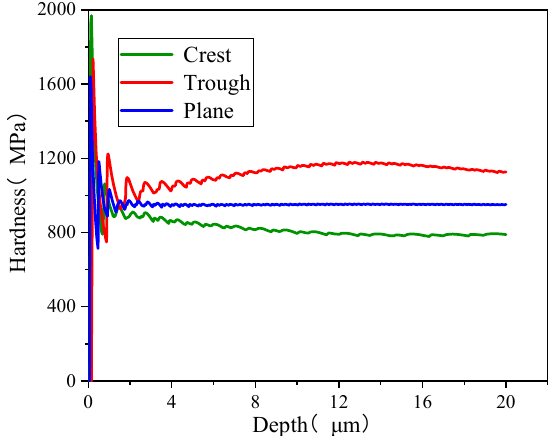
Figure 9. Hardness–depth curves of different contact positions.